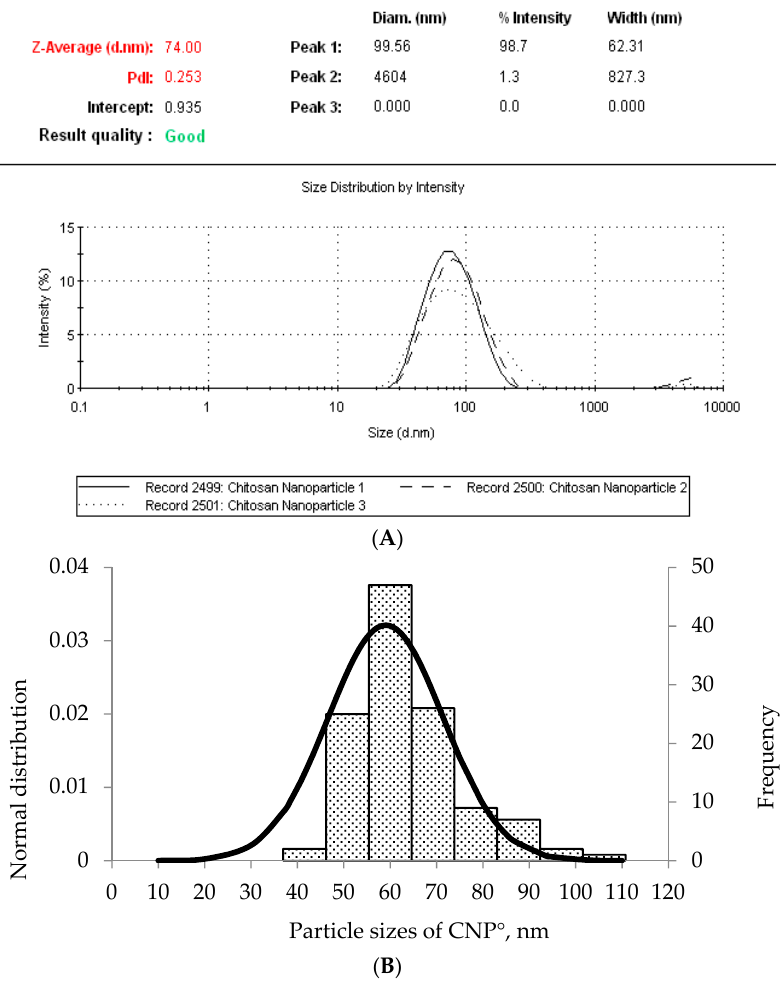
Figure 7. ( A ) Dynamic Light Scattering (DLS) result of CNP° and ( B ) normal distribution and frequency graphs of CNP° particle sizes (nm) obtained by measuring particle size in FESEM image in (Figure 6A) using ImageJ software. Comparable particle size range of CNP° was observed between DLS (80.89 ± 5.16 nm) and FESEM (50 nm and 70 nm). The slight difference between the two analysis is because DLS measures the particle size in hydrodynamic condition, while FESEM measures in a dry condition.